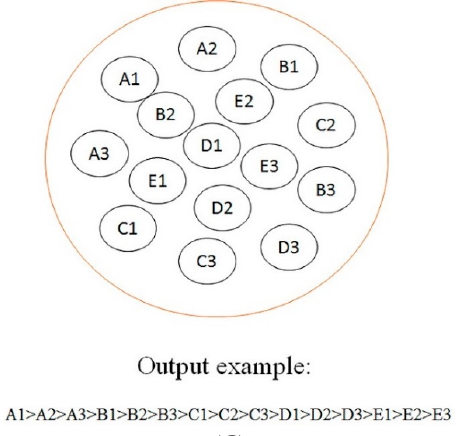
Figure 2. ( A ) Our models; ( B ) rule-based models; ( C ) other ligand-based models and structure-based models. A comparison among our models, rule-based models, ligand-based models, and structure-based models. A1, A2, and A3 represent the sites of metabolism (SOMs) of aliphatic C -hydroxylation; B1, B2, and B3 represent the SOMs of N -dealkylation; C1, C2, and C3 represent the SOMs of aromatic C -hydroxylation; D1, D2, and D3 represent the SOMs of O -dealkylation; E1, E2, and E3 represent the SOMs of other type of biotransformations.